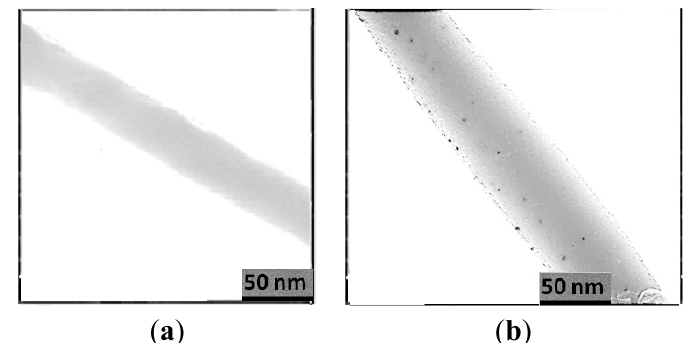
Figure 3. TEM image of electrospun PCL/MAA graft copolymer nanofiber without AgNPs ( a ) and containing AgNPs ( b ).